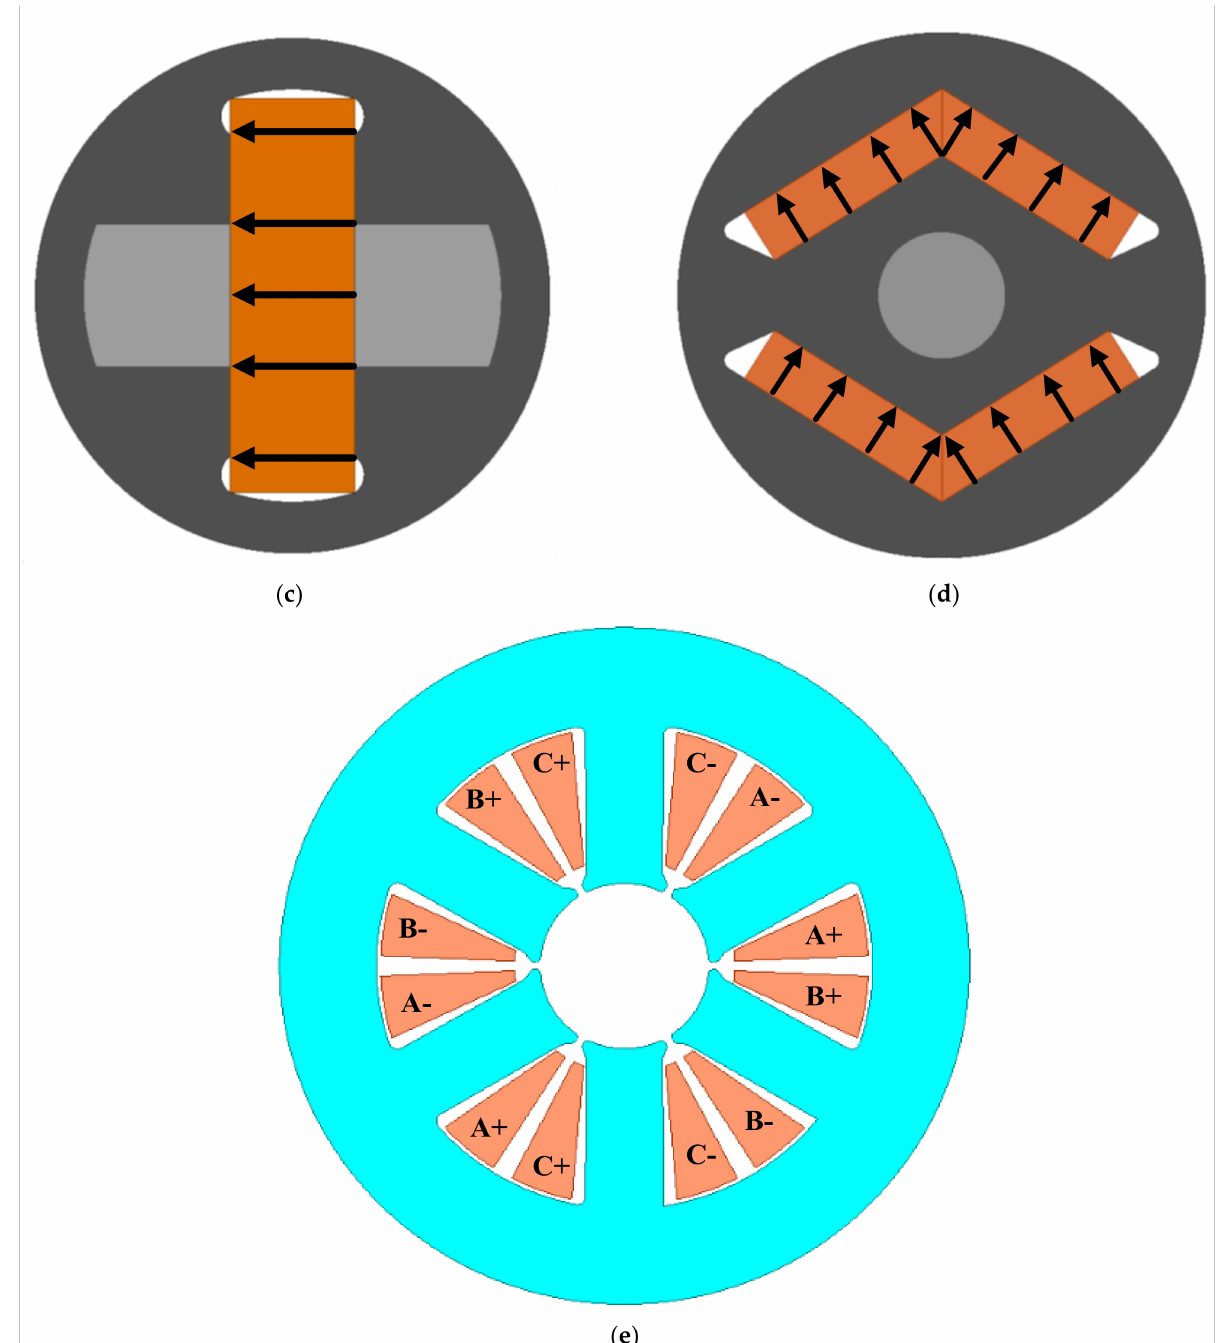
Figure 1. 19 kW HSPMSM configuration. ( a ) M1, rotor with a solid PM cylindrer; ( b ) M2, rotor with segmented magnet; ( c ) M3, rotor with interior magnet; ( d ) M4, rotor with V-shaped interior magnet; ( e )